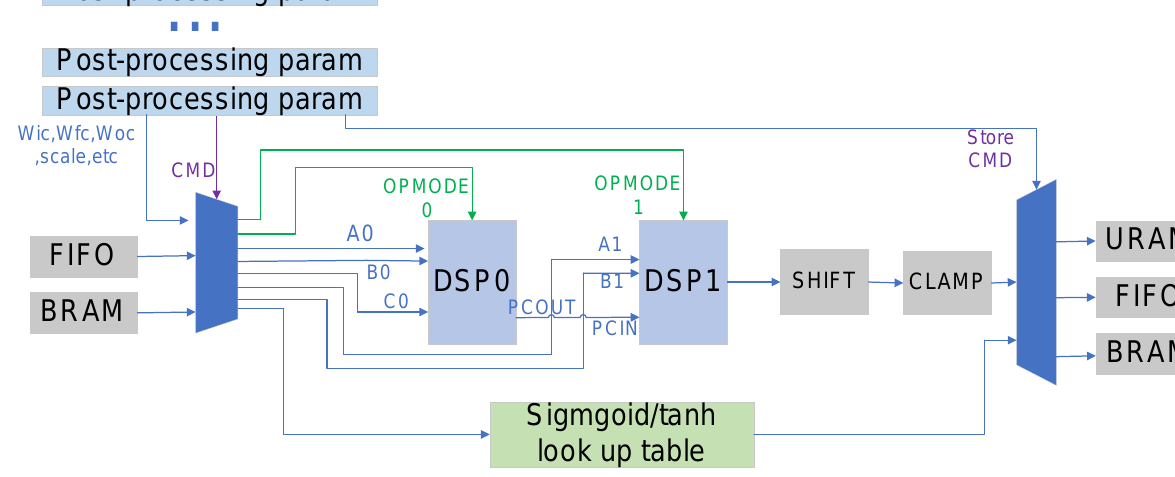
Figure 6. Structure of the post-processing